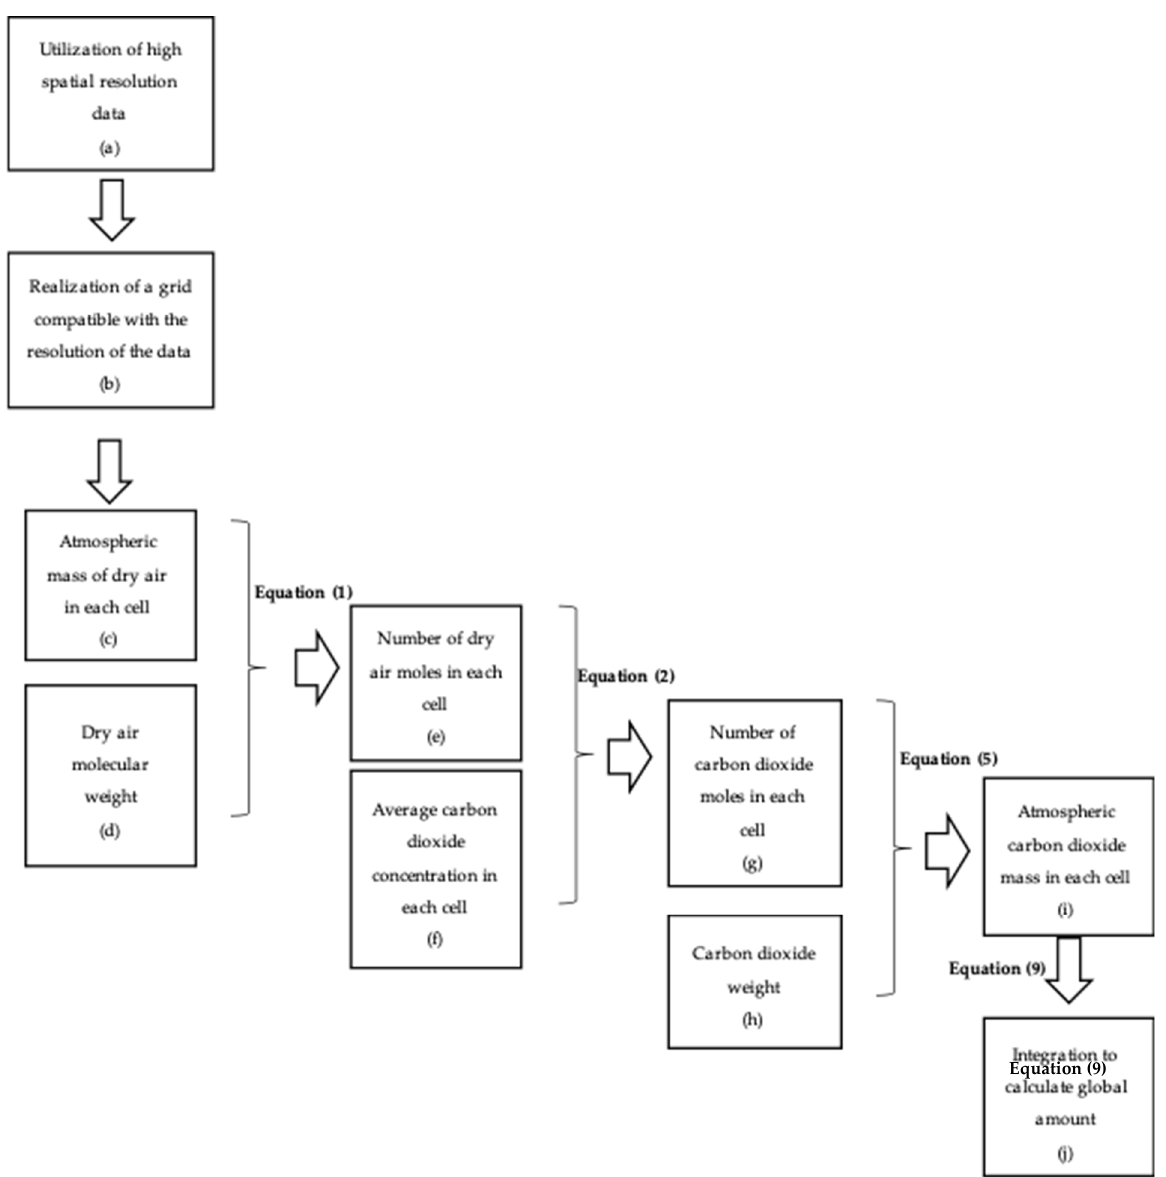
Figure 2. Building blocks for the proposed methodology to reach a higher accuracy of the results for global atmospheric carbon content. Letters ( a – j ) are used to label the blocks in order to simplify mentioning the steps in the text.